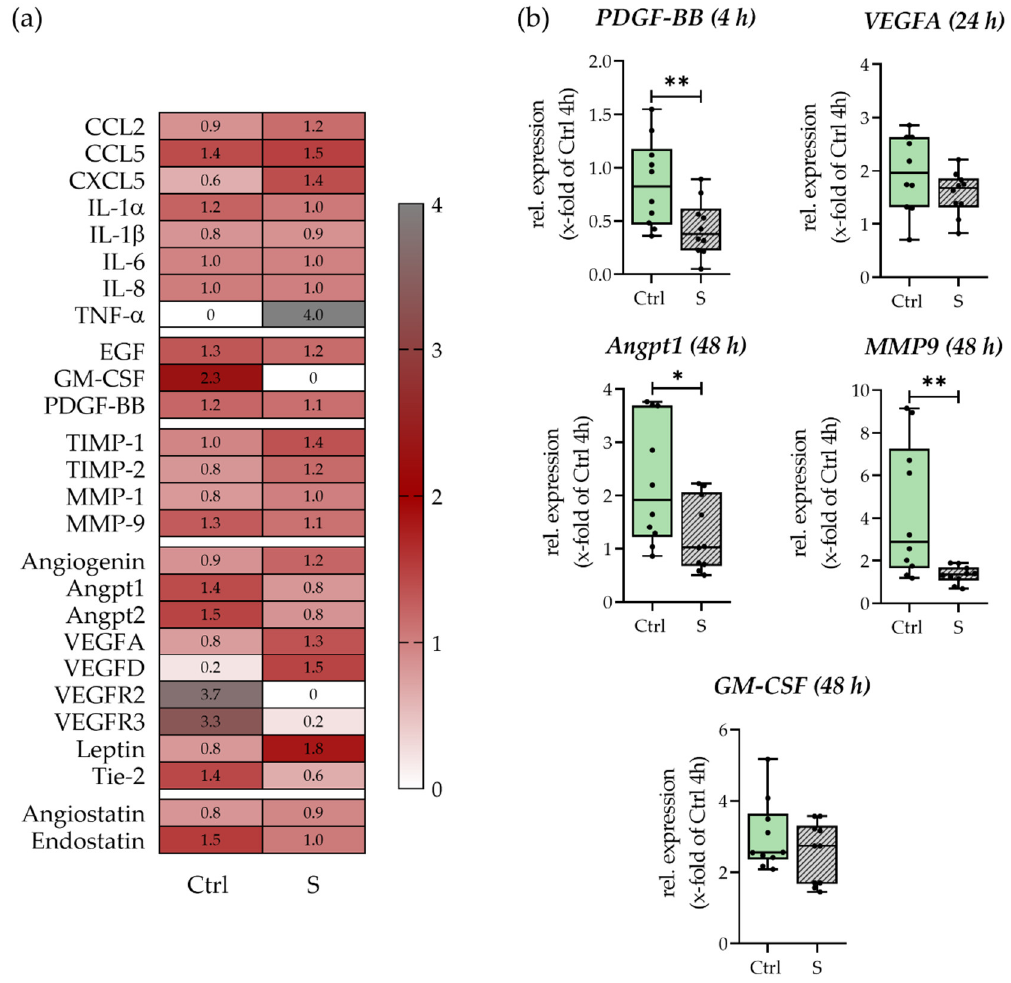
Figure 5. Analysis of angiogenesis-stimulating factors of smokers’ (S) and non-smokers’ (Ctrl) in vitro fracture hematomas. With ( a ) Secretion of angiogenic factors determined by angiogenesis array. Data are displayed normalized to the overall mean of each target. N = 5 (pooled), n = 4. ( b ) Gene expression of pro-angiogenic factors VEGFA , Angpt1 , MMP9 , PDGF-BB , and GM-CSF . N = 5, n = 2. * p < 0.05, ** p < 0.01.